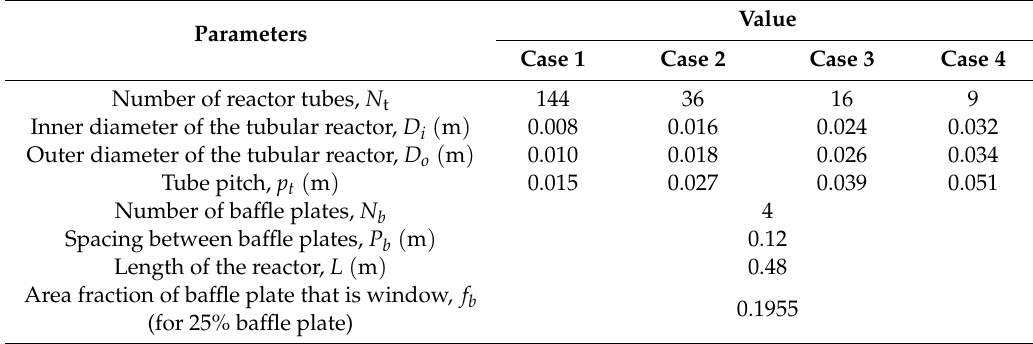
Table 6. Geometric parameters of the packed-bed reformer with variation in the number and diameter of tubes.